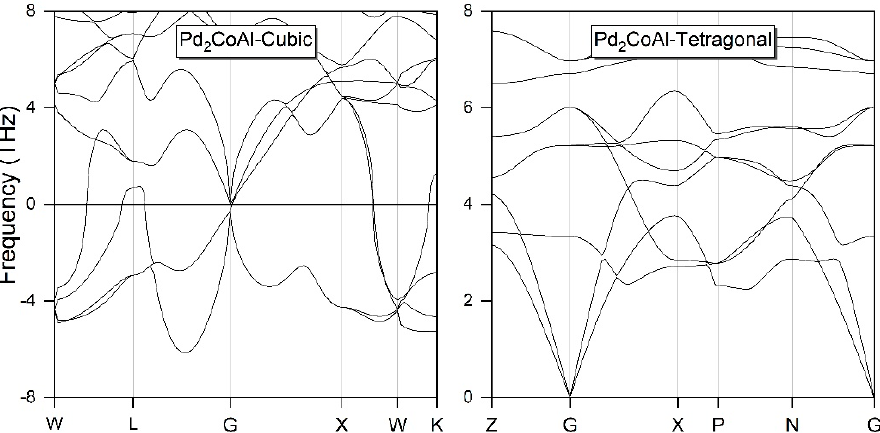
Figure 10. The calculated phonon dispersion spectrum along high symmetry points for the full Heusler compound Pd 2 CoAl in L2 1 -type cubic and tetragonal structures.